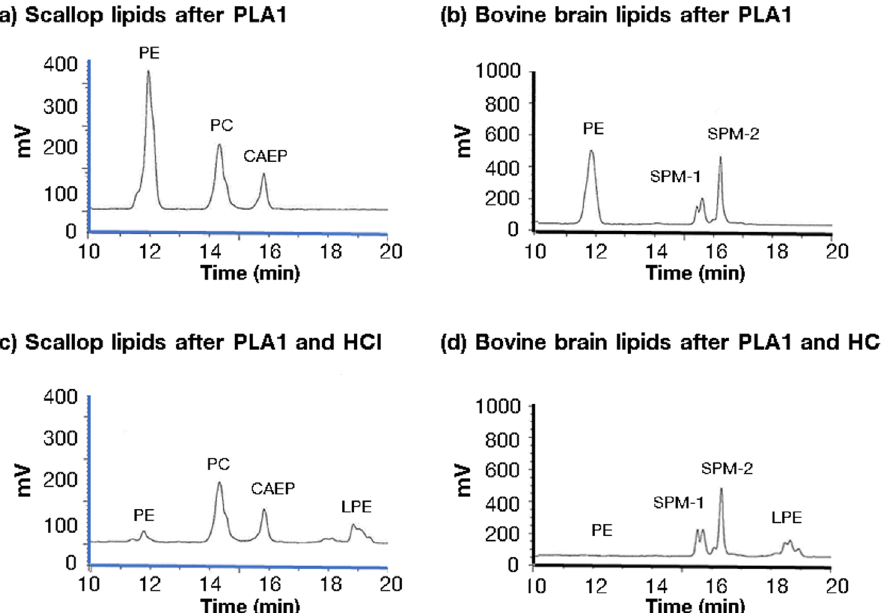
Figure 2. Chromatograms depicting HPLC profiles of scallop- or bovine brain-derived EPl, using the HPLC- ELSD system. Ether phospholipids from scallop ( a ) or bovine brain ( b ) after phospholipase A1 hydrolysis. Ether phospholipids from scallop ( c ) or bovine brain ( d ) after phospholipase A1 hydrolysis and HCl hydrolysis. CAEP, ceramide aminoethylphosphonate; ELSD, evaporative light scattering detector; HCl, hydrogen chloride; HPLC, high-performance liquid chromatography; LPE, 1-palmitoyl-2-hydroxy-sn-glycero-3-phosphoethanolamine; mV, milli-voltage; PC, 1,2-dipalmitoyl-sn-glycero-3-phosphocholine; PE, 1,2-dipalmitoyl-sn-glycero-3-phosphoethanolamine; PLA1, phospholipase A1; SPM: